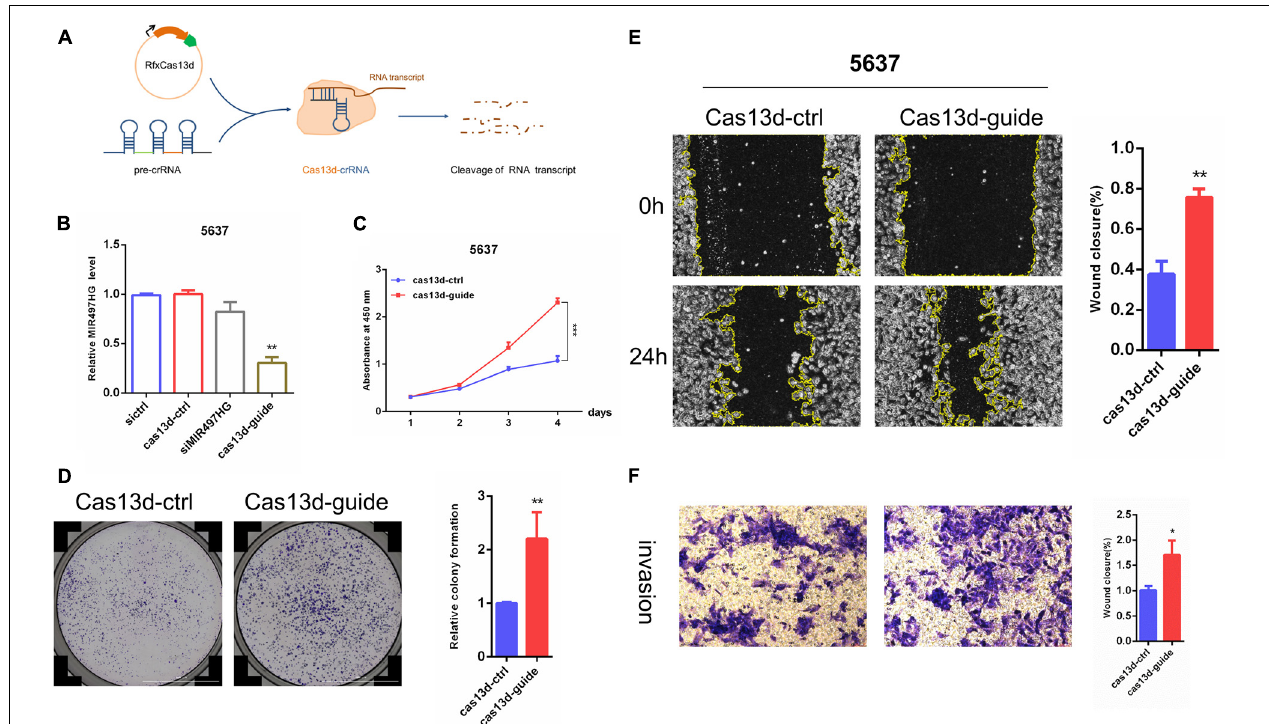
FIGURE 2 | MIR497HG suppresses BCa cell growth, migration, and invasion in vitro . (A) The schematic of CRISPR/Cas13d system. (B) Knockdown of MIR497HG with Cas13d compared with corresponding RNAi. (C) The CCK-8 assays showed that silencing of MIR497HG promotes BCa cell proliferation in 5637 cell line. (D) Clonogenic assay was performed to measure the capacity of foci formation in 5637 cells stably expressing indicated plasmids. (E) Wound healing assay of 5637 cells stably expressing indicated plasmids. (F) Representative images of Transwell invasion assay for MIR497HG-silencing 5637 cells. Cell number was counted in six randomly captured pictures. Invasive ability was normalized to control. Data are shown as mean ± SD. n = 3 for technical replicates. * P < 0.05, ** P < 0.01, and *** P < 0.001. P values are calculated by Student t test.